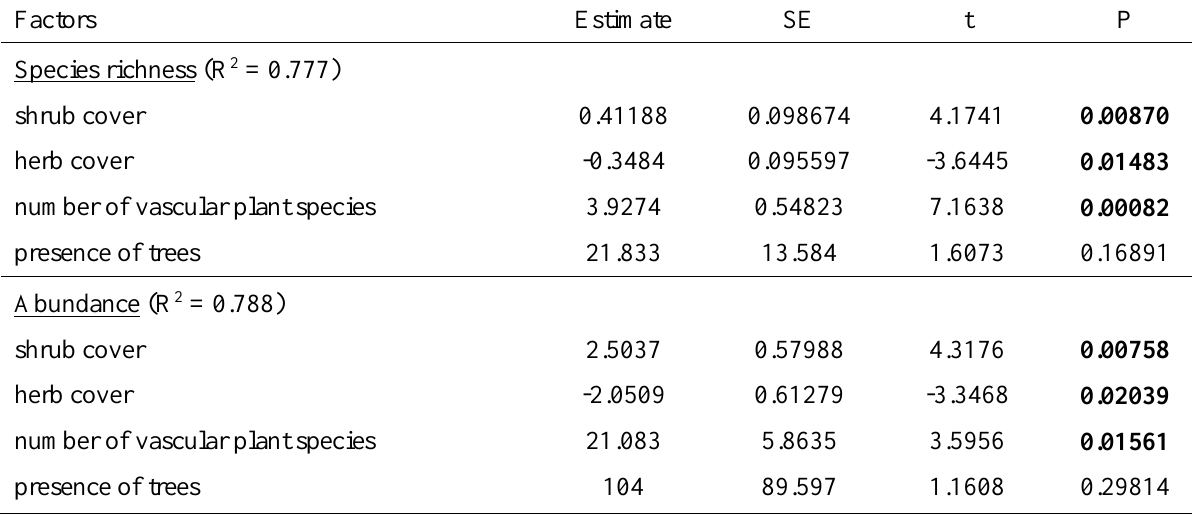
Table 3. Relationship of total Coleoptera species richness and abundance to environmental factors (generalised linear model with log transformed data, multiple regression).